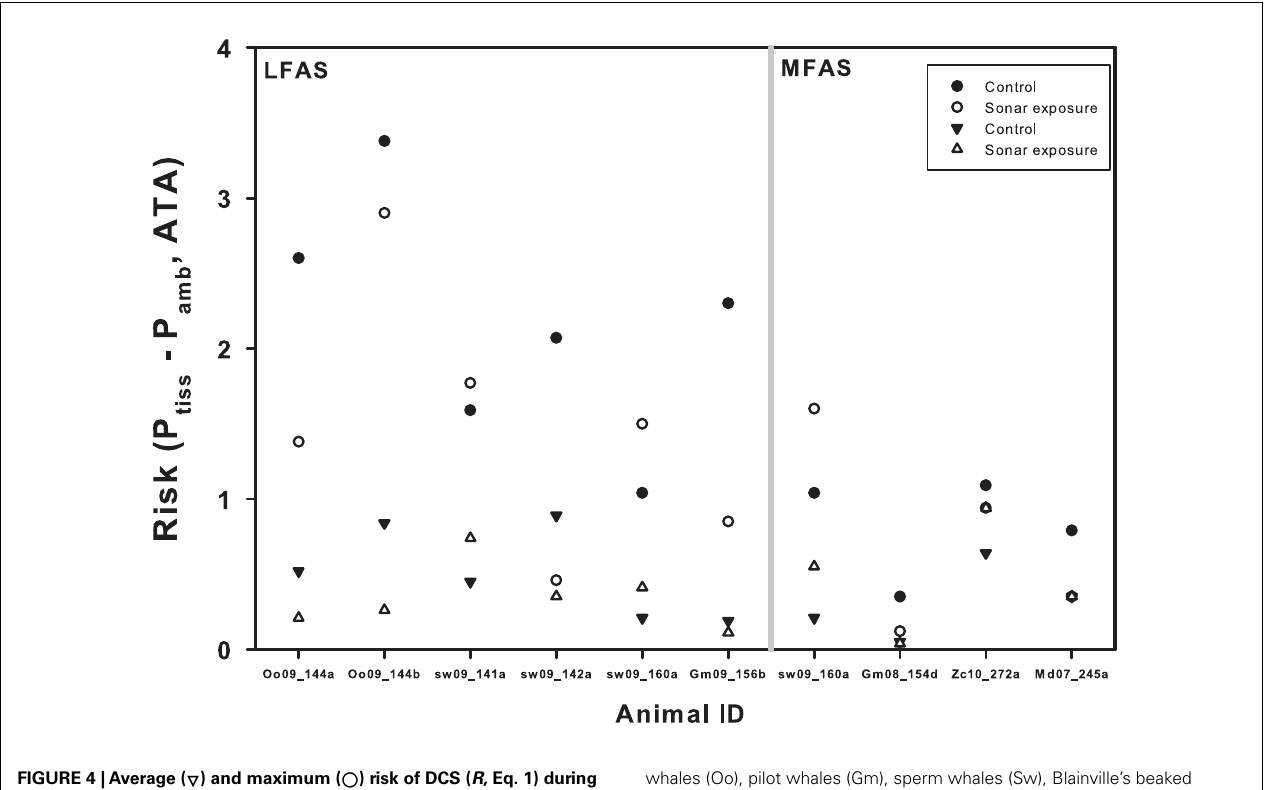
FIGURE 4 |Average ( (cid:2) ) and maximum ( (cid:3) ) risk of DCS ( R , Eq. 1) during pre-sonar control (solid symbols) and sonar exposure periods (open symbols) in behavioral “responders”. LFAS (left) and MFAS (right). Killer